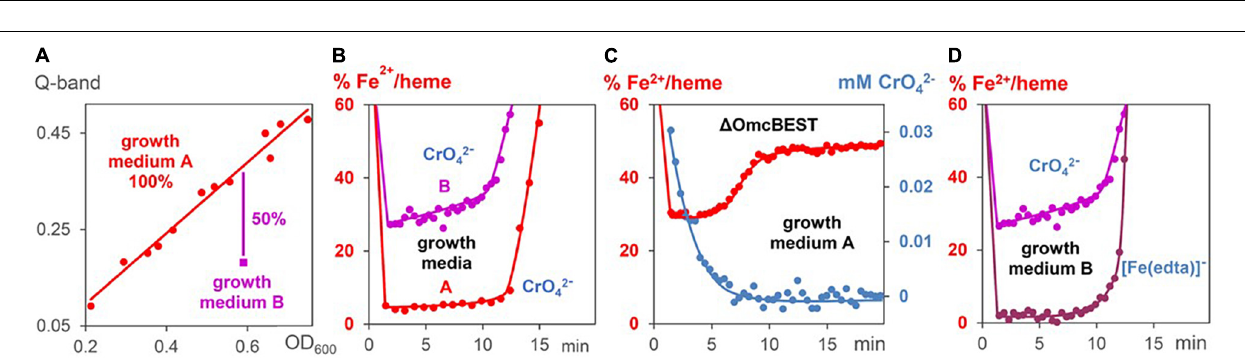
FIGURE 4 | CrO 42 − induce respiration of G. sulfurreducens , starting from the log phase. (A) Fumarate- respiring growth of G. sulfurreducens . Bacteria after 30 and 36 h growth, respectively, were used for metal induced respiration of G. sulfurreducens in the log phase. (B) Fe 2 + /heme levels during CrO 42 − induced respiration of bacteria starting from log phases 1 and 2, as well as the resting (lag) phase. (C) Reduction of CrO 42 − (0.05 mM) by bacteria (0.63 ± 0.2 pM) in the log phase 1 and the lag phase. (D) Reduction of CrO 42 − (0.1 mM) by bacteria (0.83 ± 0.2 pM) in the log phase 2 and the lag phase.